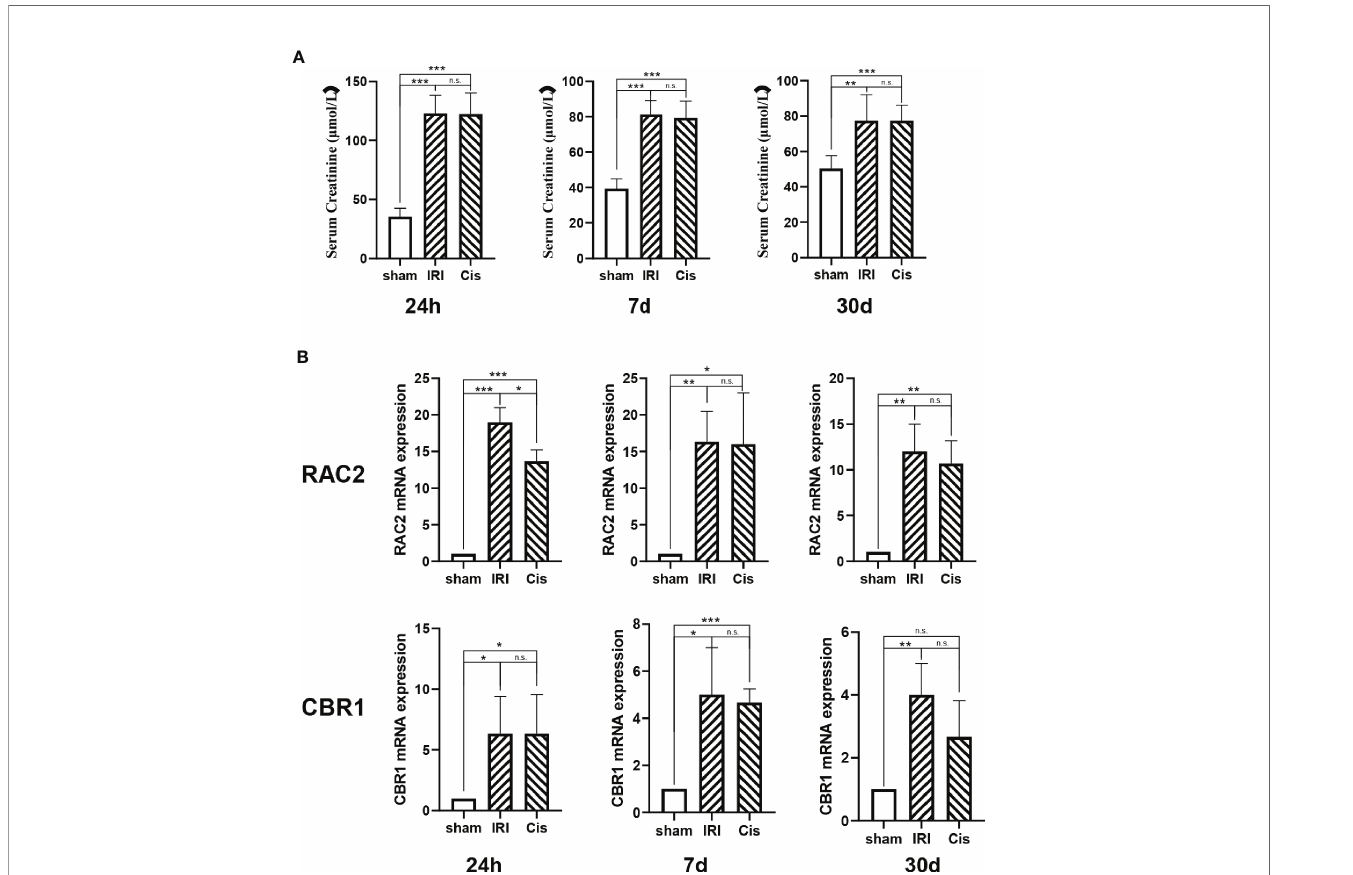
FIGURE 6 | RAC2 and CBR1 mRNA expression in each group. (A) Serum Creatinine in sham, IRI, and Cisplatin group after 24 h, 7 d, and 30 d. (B) mRNA expression of RAC2 and CBR1 in T cells from kidneys and kidneys. ***P < 0.001, **P < 0.01, *P < 0.05, n.s., no signi fi cant